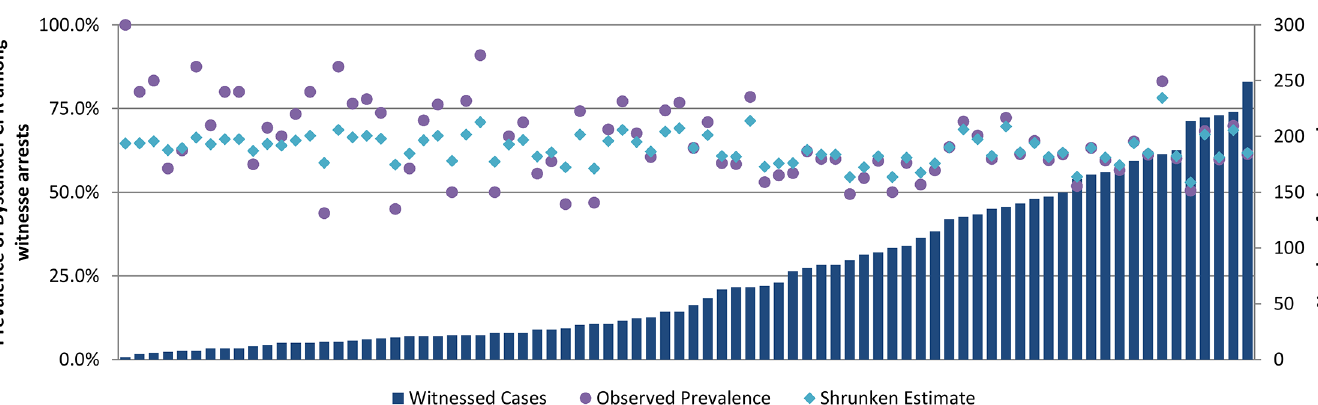
PLOS ONE | DOI:10.1371/journal.pone.0139776 October 8, 2015 5 /